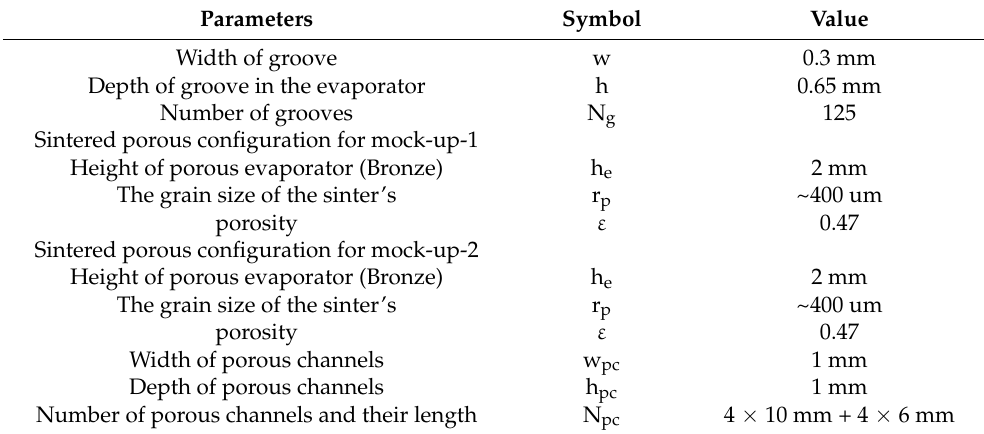
Table 1. Parameters of wick structures: grooves at adiabatic zone and sintered porous evaporators.